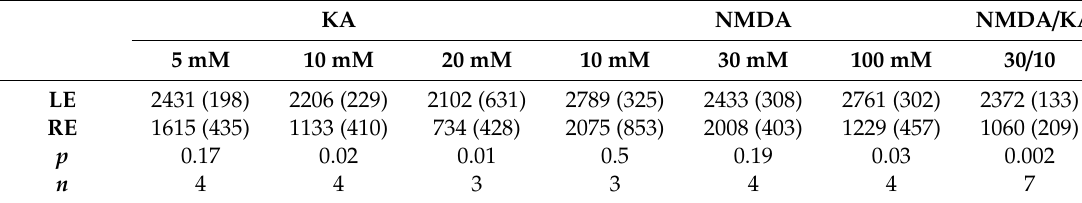
Table 1. RGC densities estimated after the individual administration of KA and NMDA, and the joint administration of NMDA / KA. RGC densities are expressed as arithmetic mean and standard deviation (DS). The number of animals used in each case is indicated, as well as the statistical significance ( p ) of the comparative analysis between the control left eye (LE) and the experimental right eye (RE) (Student’s t